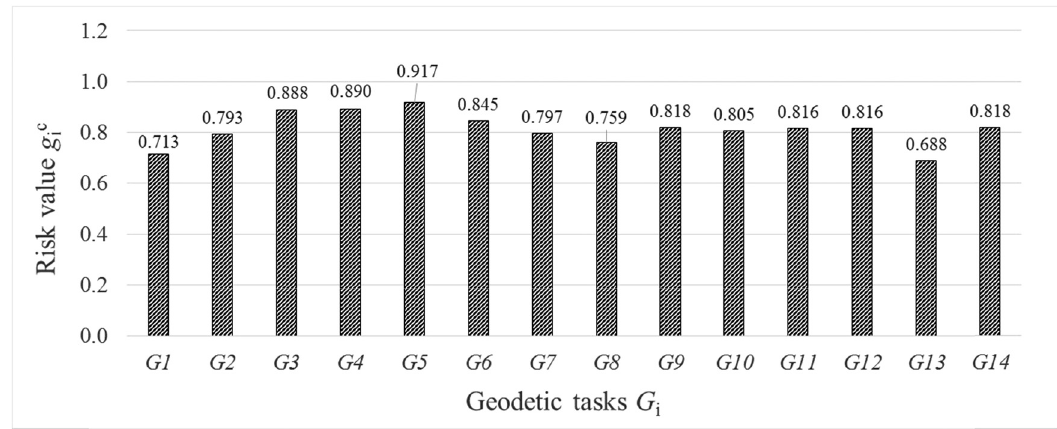
Figure 3: The risk value for the i - th geodetic task considering the increased costs of